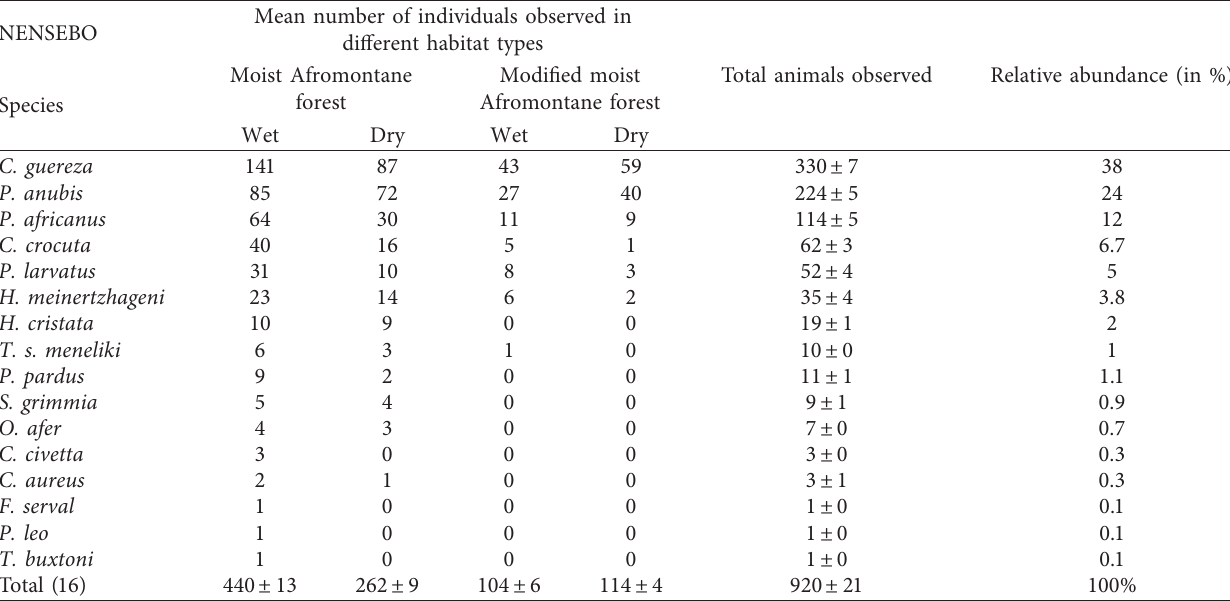
Table 3: Relative abundance and mean abundance of large wild mammals among different habitat types of Nensebo forest, Southern Ethiopia.